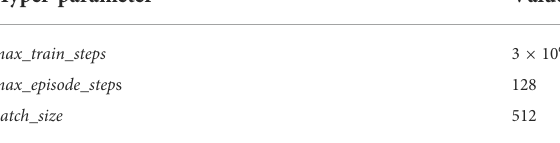
TABLE 9 The hyperparameter settings involved in Algorithm 1.